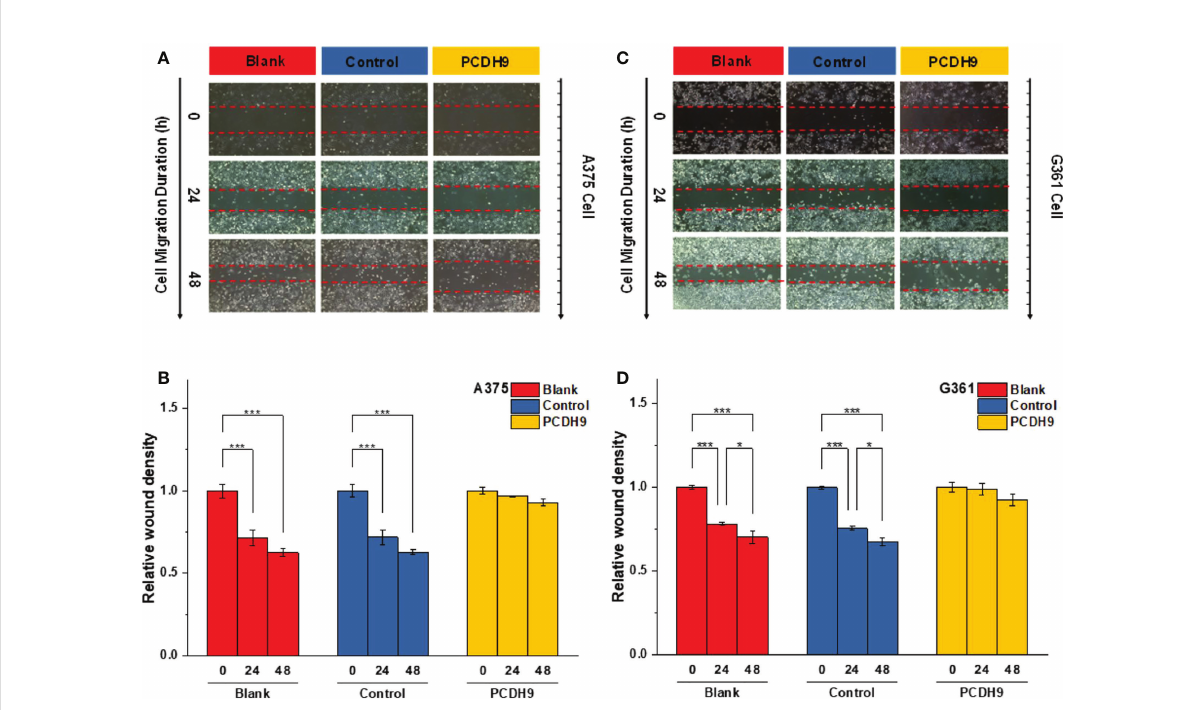
FIGURE 6 The scratched boundary of migrator cells was observed by inverted microscope DMI3000B (Leica, Germany). Representative image of melanoma cells invaded from the scratched boundary in A375 (A) and G361 (C) cell lines. Relative density of scratched boundary was not altered in overexpressed PCDH9 groups comparing with blank and control groups in A375 (B) and G361 (D) cell lines. * p < 0.05, and *** p < 0.001 compared in groups by using one-way ANOVA followed by least signi fi cant difference post hoc